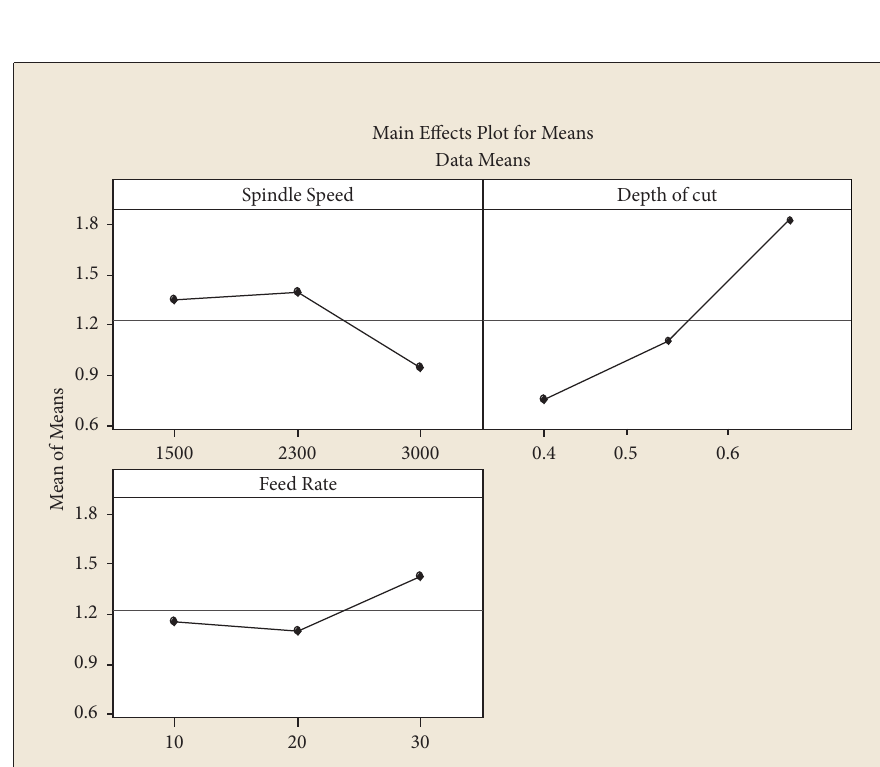
Figure 5: Means plot for R